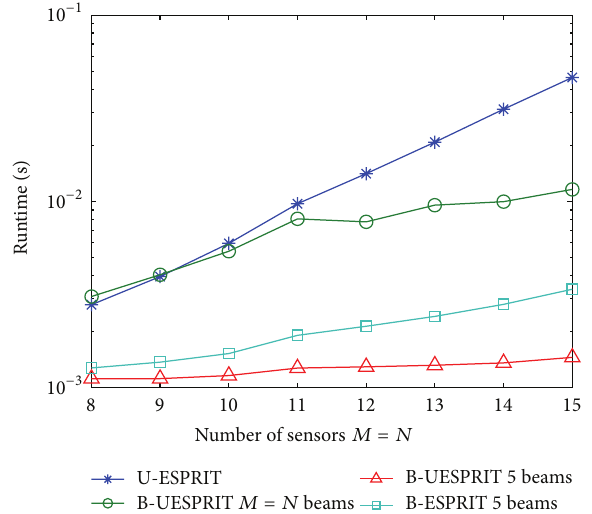
Figure 7: RMSE of DOA versus SNR for 3 sources with different values of sample.